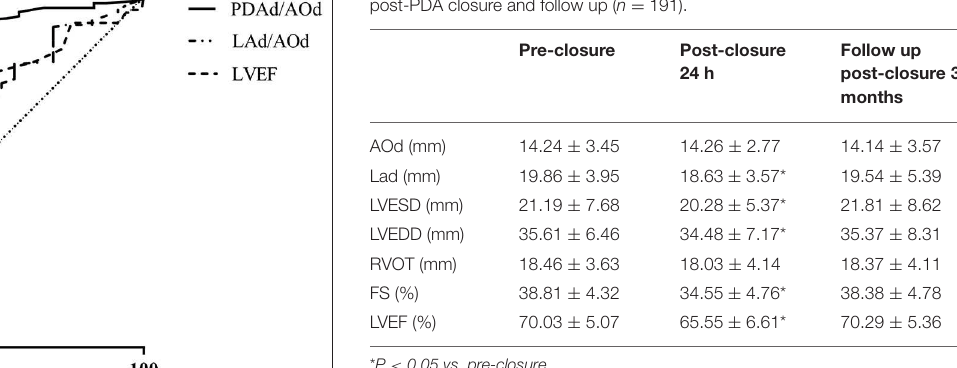
TABLE 2 | Comparison of echocardiography parameters at pre-closure, post-PDA closure and follow up ( n = 191).